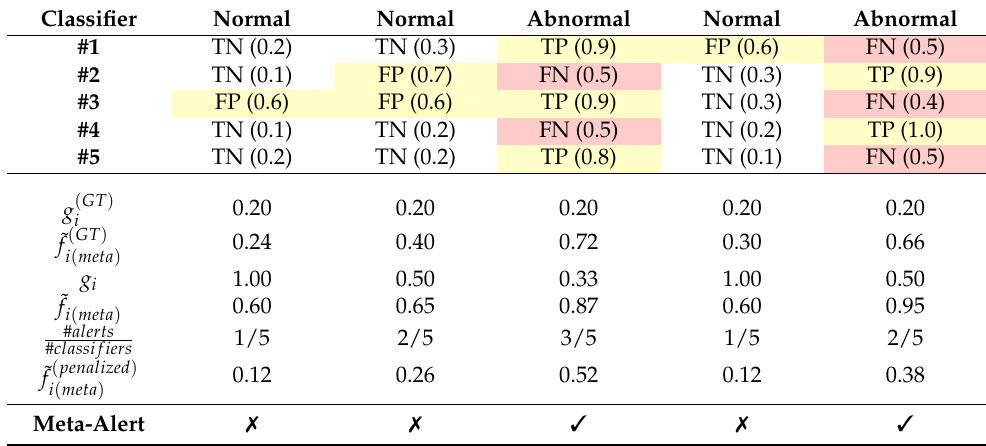
Table 1. Exemplary meta-alert generation based on five online OD algorithms classifying five data instances (3 × normal, 2 × abnormal) (yellow-colored background for alerts generated by each classifier for True Positives ( TP ) and False Positives ( FP ); red-colored background for critical False Negatives ( FN ); ( GT ) denotes if Ground Truth about the binary classification was